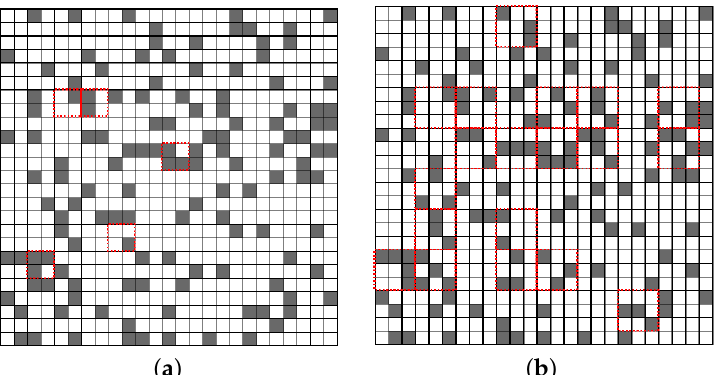
Figure 8. Marked SAs. ( a ) Marked SAs with 2 × 2 kernel. ( b ) Marked SAs with 3 × 3 kernel.